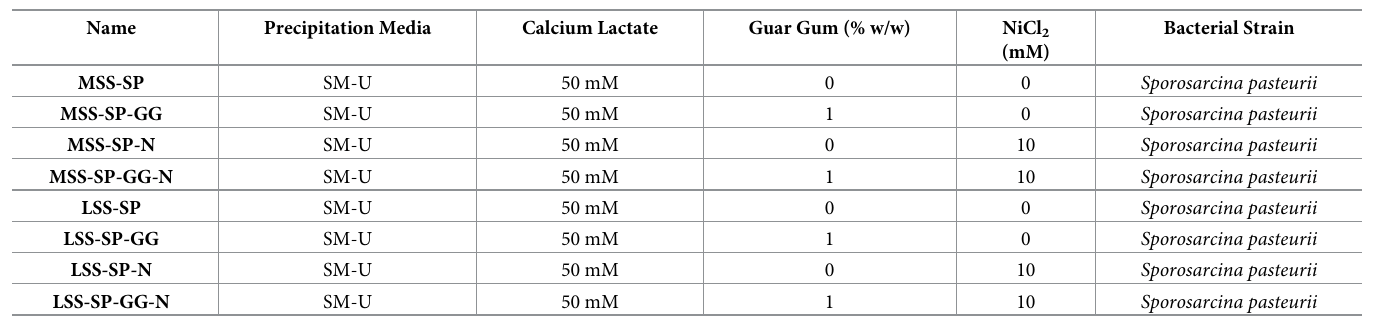
Table 1. Treatments used for bacterial induced consolidation of soil